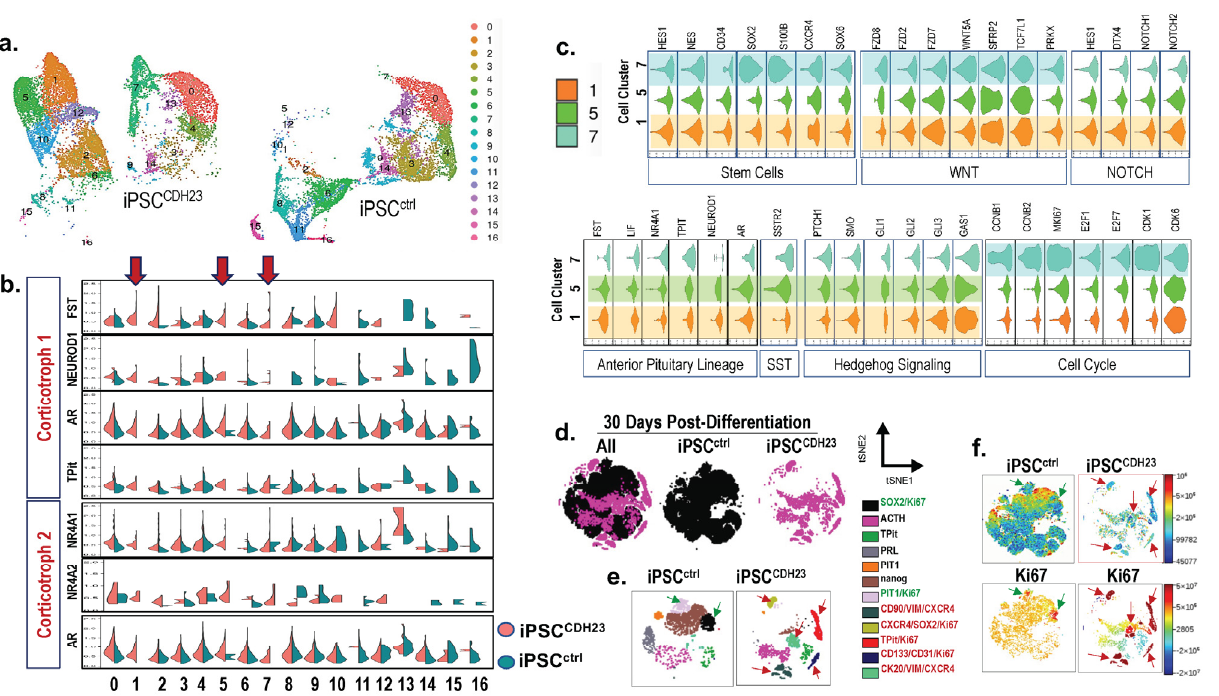
Figure 7. Single cell analysis of iPSC ctrl and iPSC CDH23 cultures 15 and 30 days post-directed differentiation. ( a ) UMAP plots showing identified cell clusters 0–16 in iPSC ctrl and iPSC CDH23 cultures 15 days post-directed differentiation. ( b ) Violin plots of representative identified markers of the corticotroph cell lineage, where 2 subpopulations were observed among iPSC ctrl and iPSC CDH23 cultures. Arrows highlight clusters 1, 5, and 7. ( c ) Violin plots showing expression of genes representative of stem cells, Wnt, NOTCH, Hh and SST signaling, anterior pituitary (corticotroph) cell lineage, and cell cycle in clusters 1, 5, and 7 of iPSC CDH23 cultures. Plot width: cell number, plot height: gene expression. ( d ) viSNE maps showing concatenated flow cytometry standard files for both samples and iPSC ctrl and iPSC CDH23 organoids 30 days post-directed differentiation. ( e ) Overlay of manually gated cell populations onto viSNE plots. ( f ) Fluorescent intensity of Ki67 of viSNE maps for both samples and iPSC ctrl and iPSC CDH23 organoids. iPSC ctrl = 22518 events; iPSC CDH23 = 17542 events.